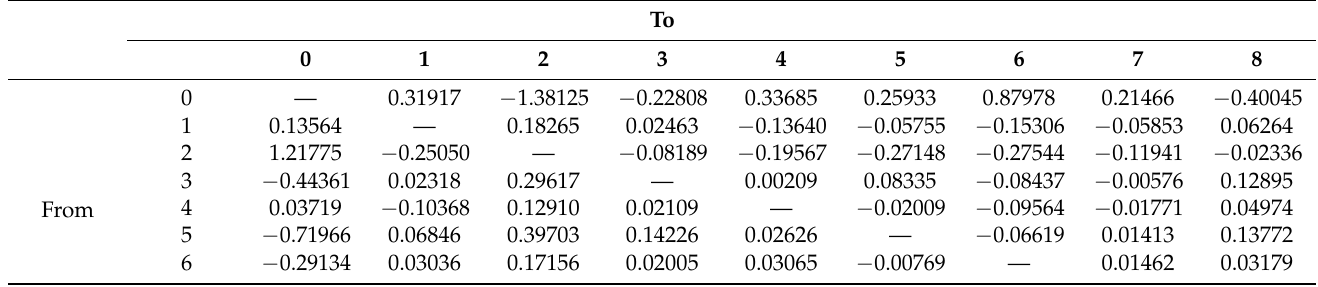
Table 6. From-to trajectory ( FTT ) matrix from 1000 random solutions for an 8-job